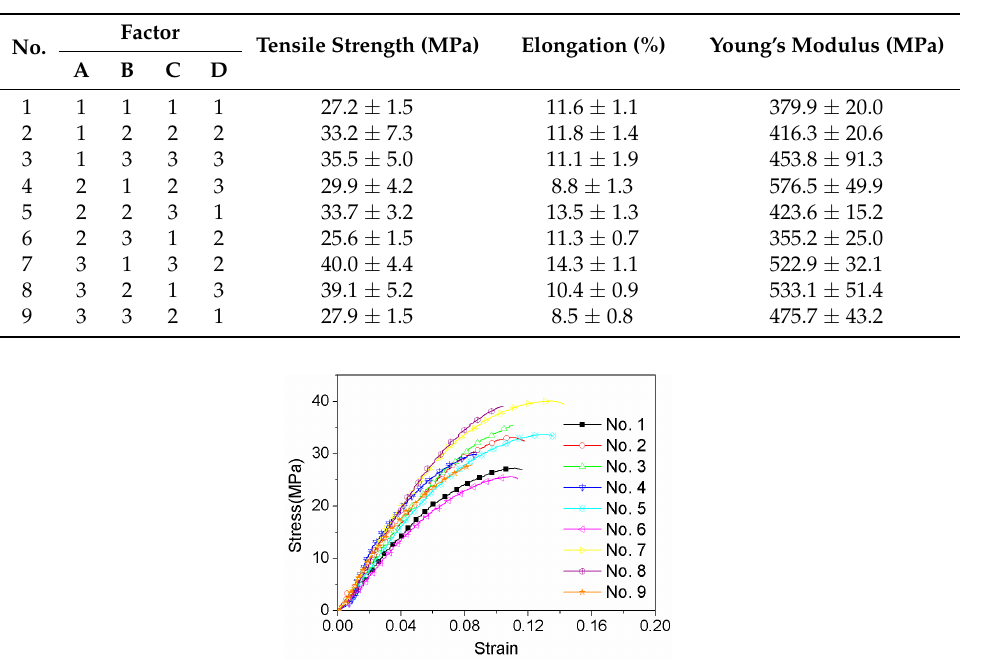
Table 3. Tensile properties of orthogonal array designed specimens.